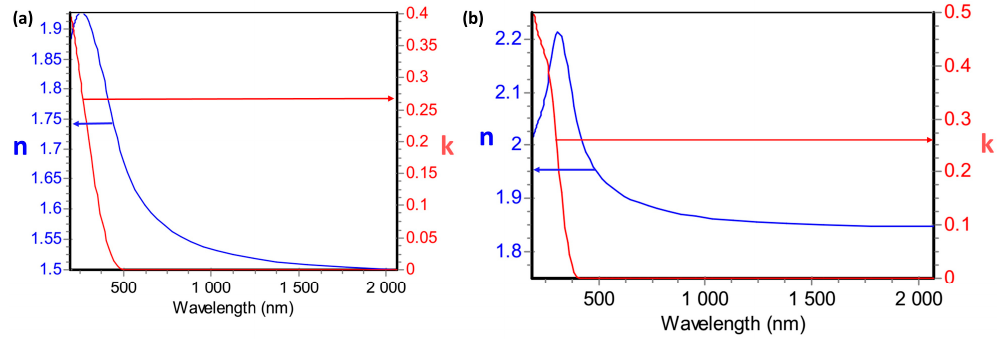
Figure 1. Optical constants of indium oxide sputtered at ( a ) low vacuum and ( b ) high vacuum.